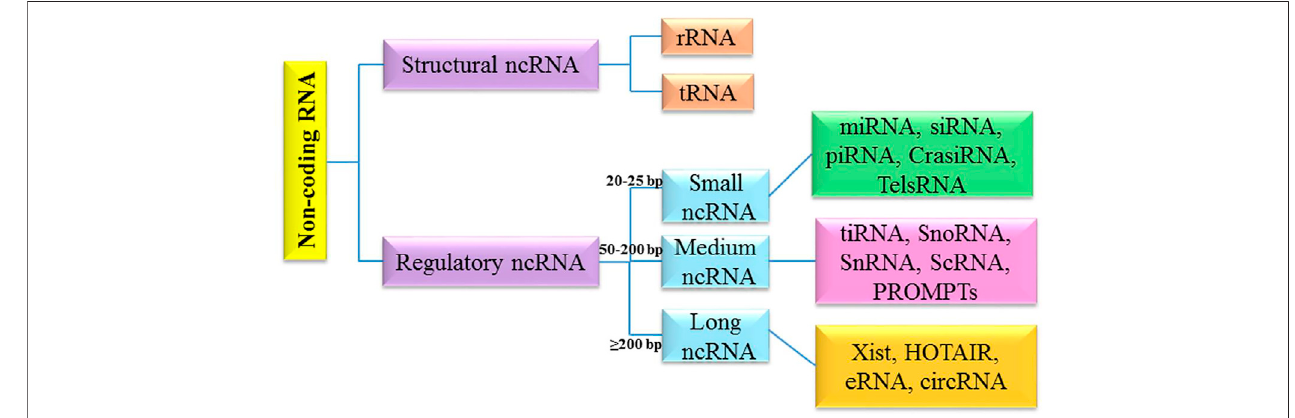
FIGURE 1 | Classi fi cation of non-coding RNAs.